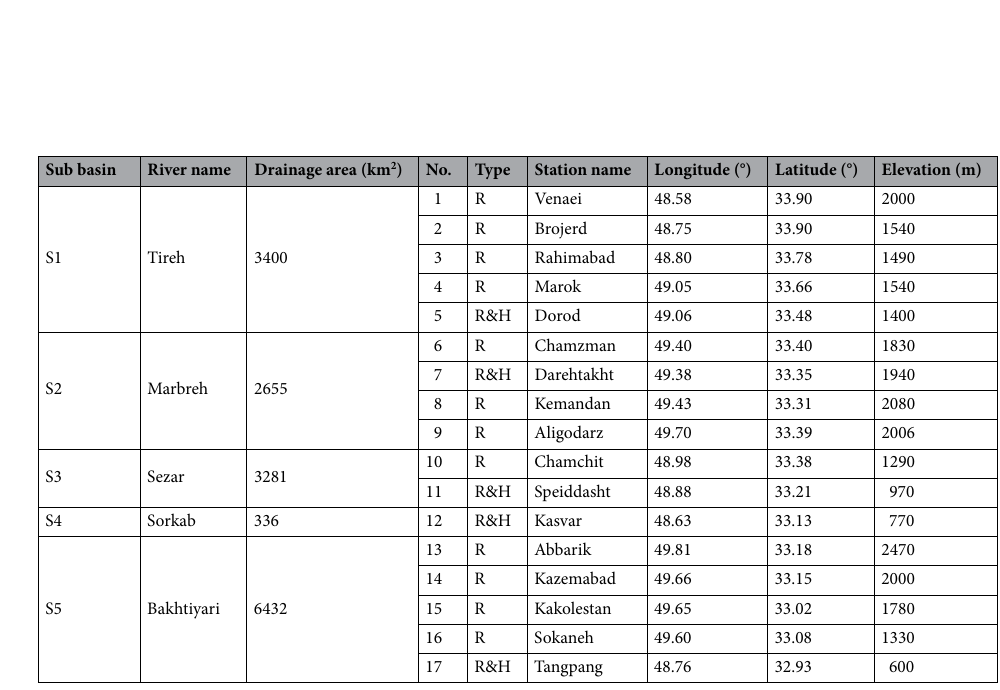
Table 1. Information for the rain gauging and hydrometric stations in the Dez Basin.